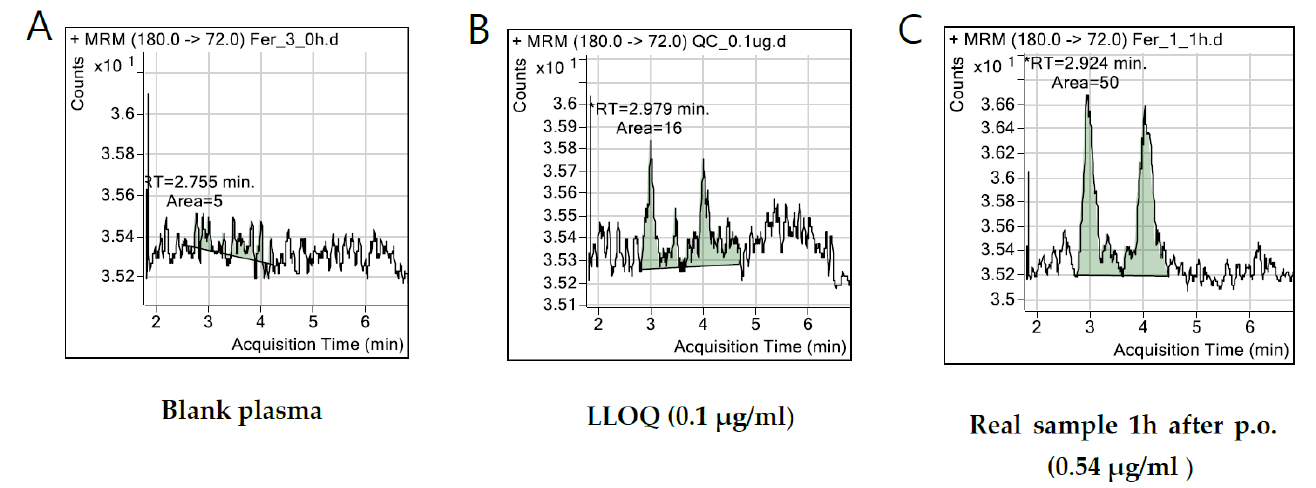
Figure 1. Representative MRM chromatograms of glucosamine in human plasma samples: ( A ) blank plasma; ( B ) blank plasma spiked with LLOQ level of glucosamine (0.1 μg/mL); ( C ) plasma samples at 1 h after an oral administration of 1500 mg of biofermentation-derived glucosamine sulfate 2KCl product to a healthy subject. Determined glucosamine concentration was 0.54 μg/mL. RT means retention time.